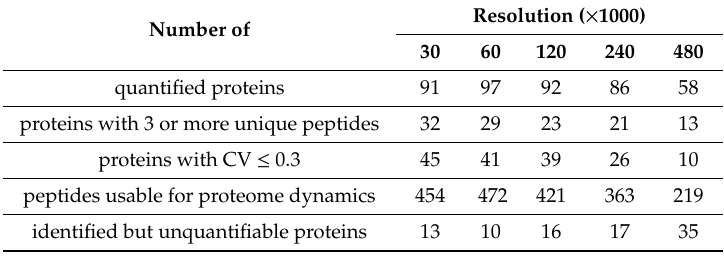
Table 1. The number of analyzed proteins at different mass resolutions of the Orbitrap Fusion.